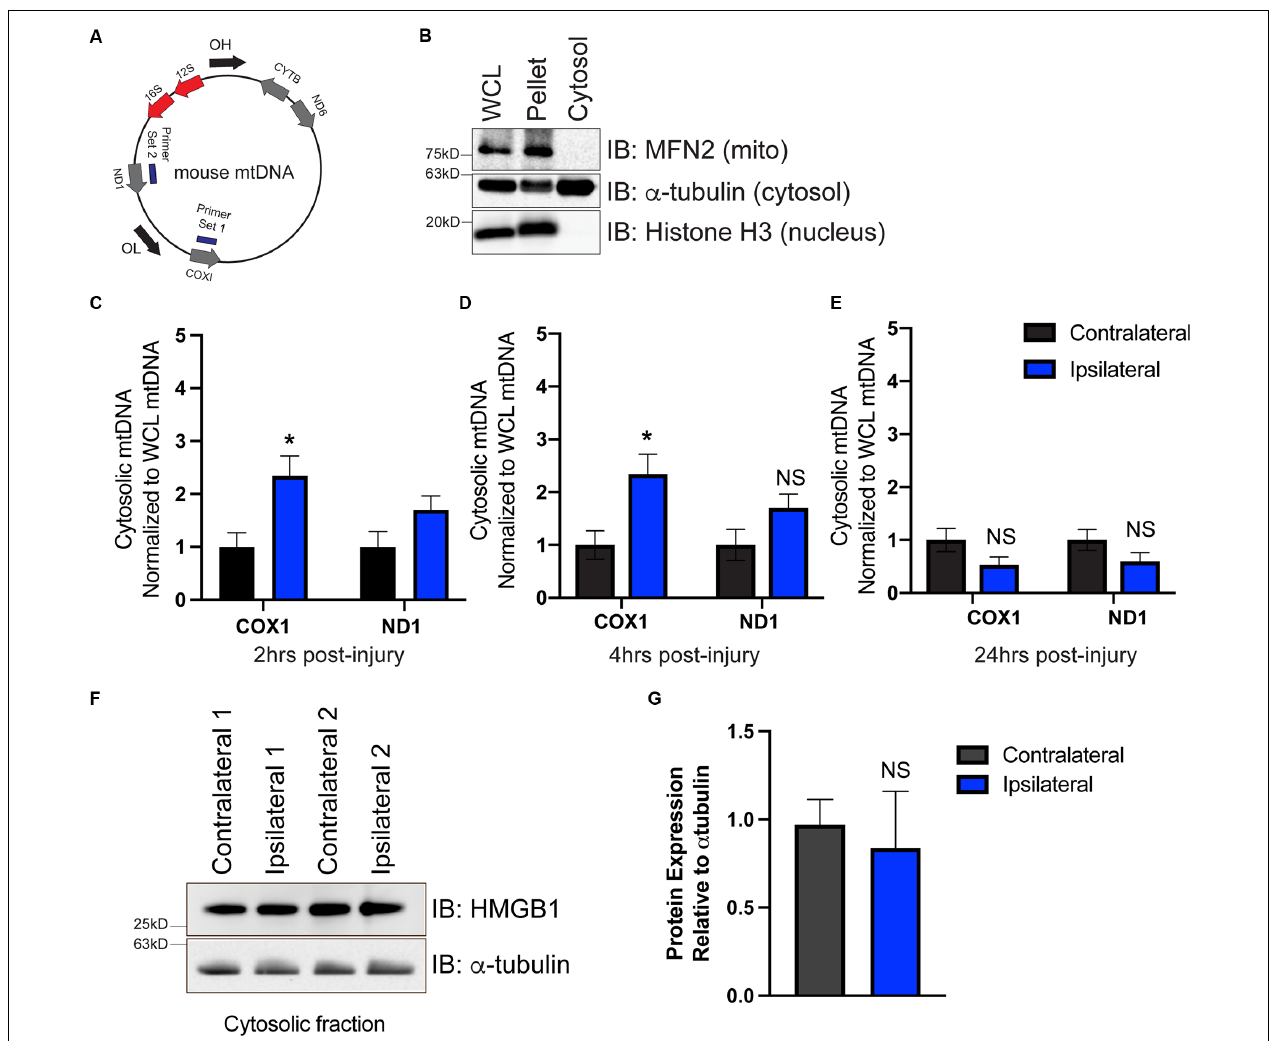
FIGURE 2 | mtDNA is present in the cytosol as a possible trigger for cGAS-STING activation after TBI. (A) Diagram of mtDNA showing primer sets for ND1 and COX1. (B) Western blot of whole cell lysate (WCL), cell pellet, and isolated cytosol to confirm cytosolic purity. Mitofusin 2 (MFN2) was used to identify mitochondria, alpha-tubulin was used for detecting cytosol, and histone H3 indicated the nuclear fraction. (C–E) mtDNA was directly detected in the cytosol via qPCR at 2, 4, and 24 h post-TBI. Each animal was normalized to the respective hemisphere’s WCL. (F) Representative western blotting of the DNA-binding protein high mobility group box protein 1 (HMGB1) in the cytosol 2 h post-TBI. (G) Quantification of HMGB1 western blot normalized to alpha-tubulin. n = 5 per group for all experiments. Data presented as mean ± SEM. * p < 0.05. NS = not